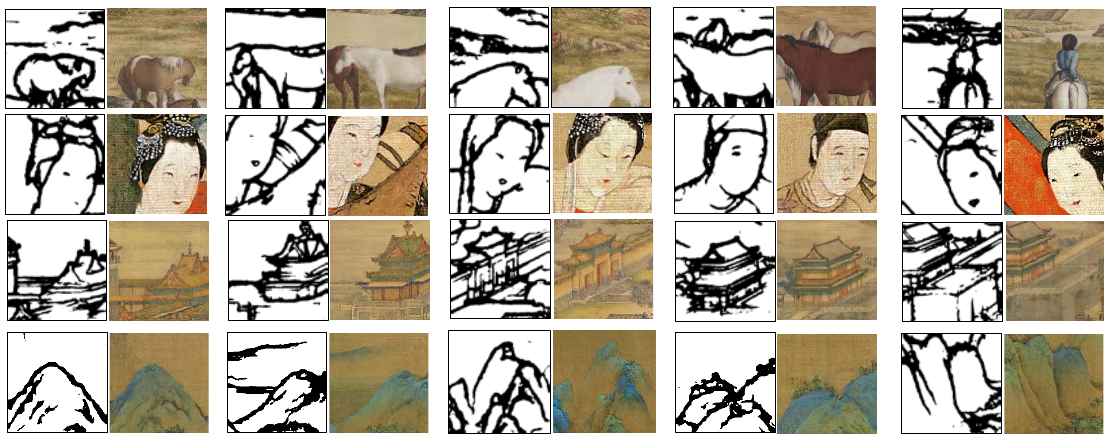
Figure 4. Our deep network takes user sketches to synthesize Chinese paintings. The input sketch can be any size, and our deep network can synthesize the Chinese painting with fine details in real time. Despite the diverse sketch styles, our network can produce high quality and diverse results. ( Left ) Input sketch; ( right ) generated Chinese painting.